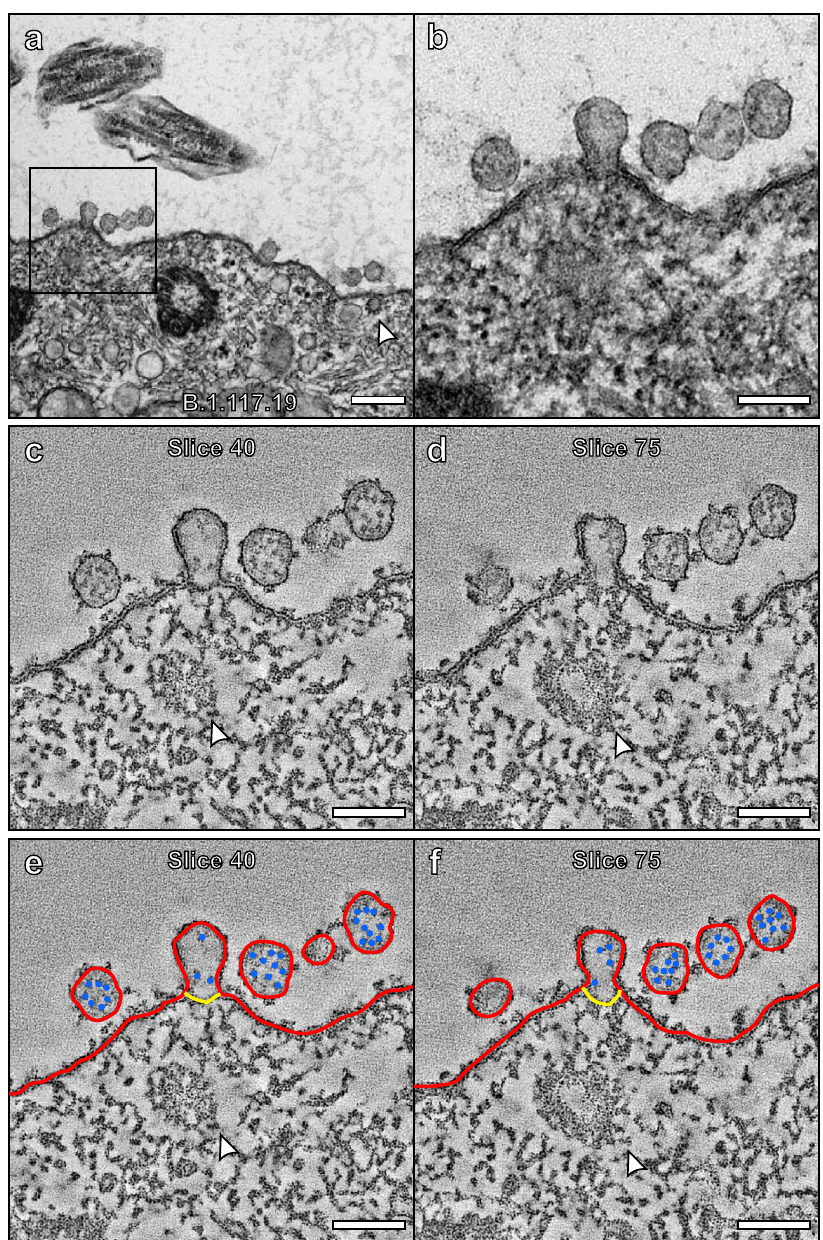
Fig. 6 SARS-CoV-2 virion fused to the plasma membrane and released its contents into a ciliated cell. a TEM image of a virion fused to a host cell and higher magni fi cation of the boxed region ( b ). c – f Tomogram generated of the attached virion with false colours ( e , f ) to indicate viral and plasma membrane (red), nucleocapsid protein (blue), and a neck-like structure (yellow). e , f The viral membrane is continuous with the host cell plasma membrane and the nucleocapsid contents are diluted as they are released into the host cell. The white arrowheads highlight a , b a clathrin-coated pit and e , f a clathrin-coated vesicle. Scale bars a 200 nm and b – f 100